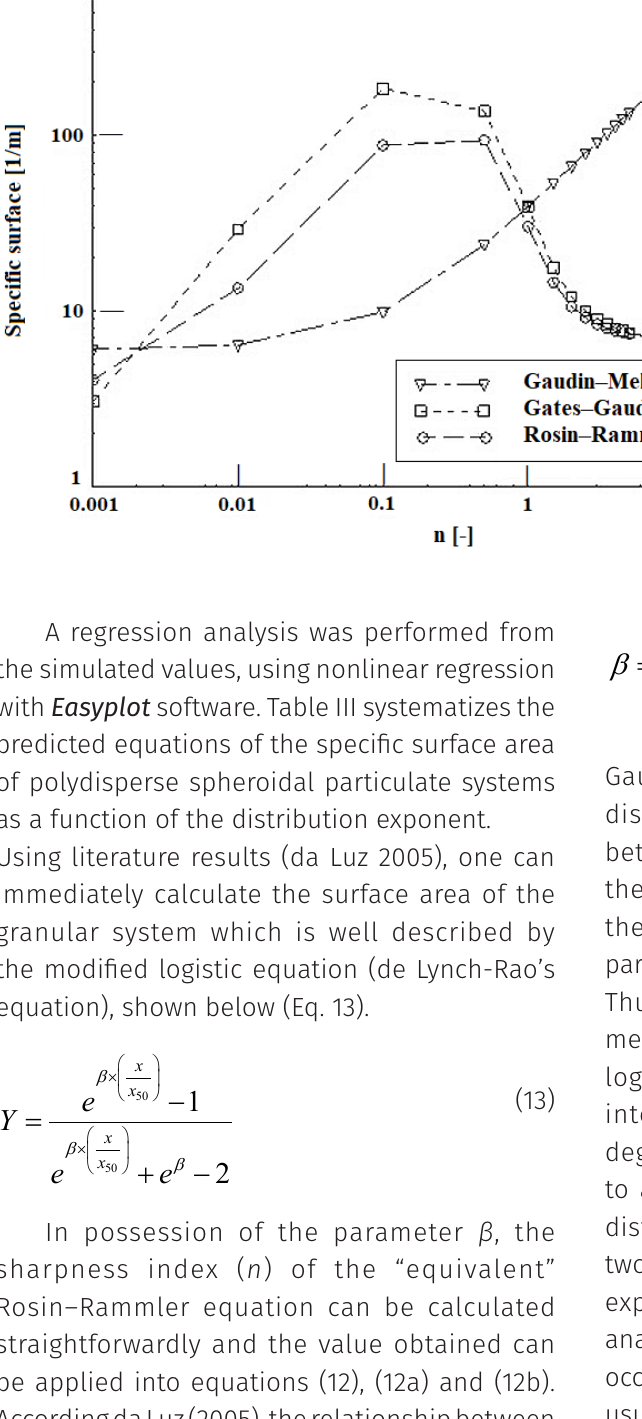
Figure 2. Specific volumetric surface area of spheroidal systems as a function of exponent n